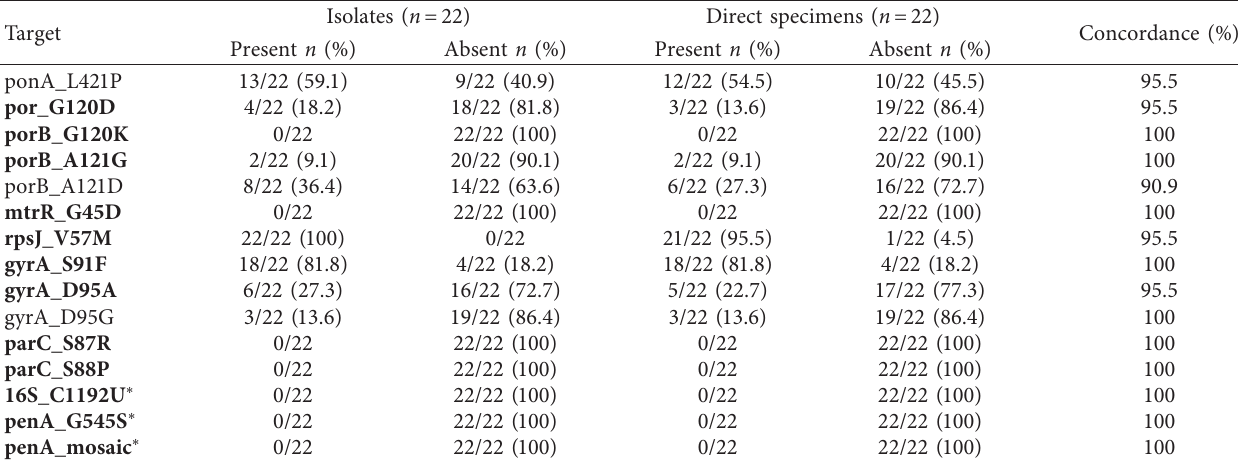
Table 4: Evaluation of high-resolution melt assay for the detection of antimicrobial resistance determinants in Neisseria gonorrhoeae clinical isolates compared to direct swab